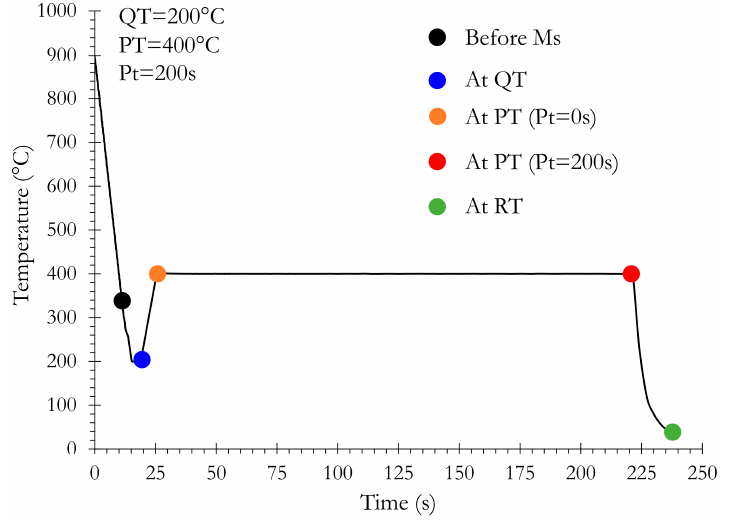
Figure 3. Critical times selected in the thermal treatment corresponding to (QT = 200 ◦ C PT / Pt = 400 ◦ C / 200 s). PT: partitioning temperature, QT: quenching temperature.